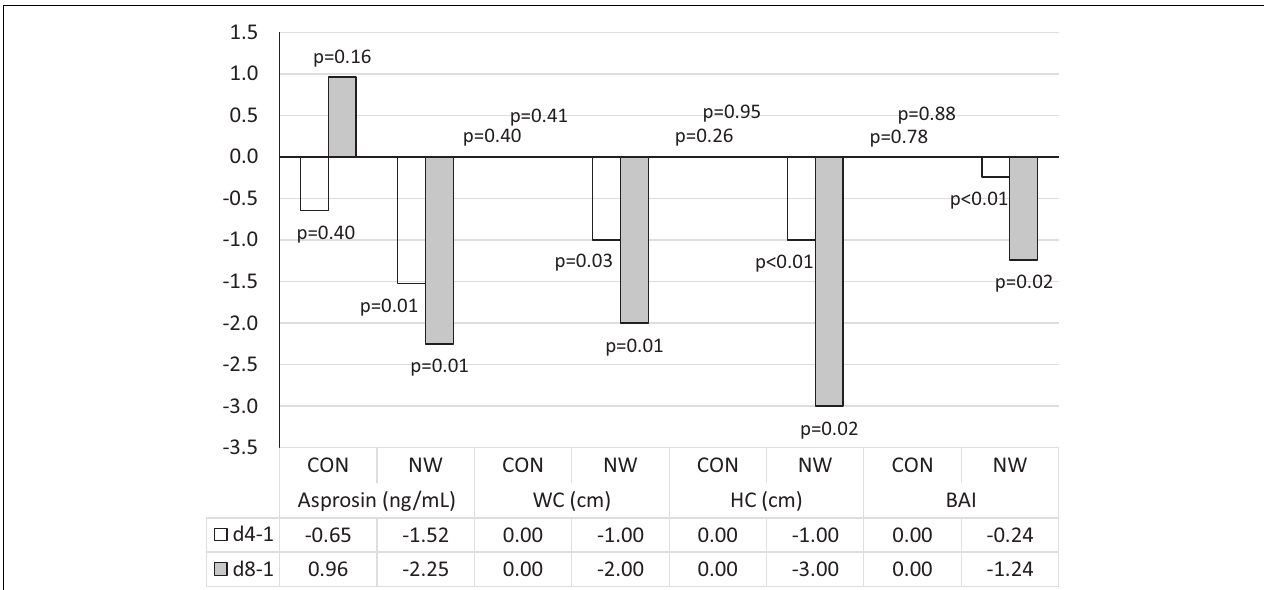
FIGURE 2 | Changes in analysed variables after 4 (d4-1) and 8 weeks (d8-1) of control (CON) tests and the Nordic walking (NW) compared to values at the beginning of the stage. Data are presented as medians (Me); p < 0.05 – statistically significant difference with regard to baseline value at a given stage; WC, waist circumference; HC, hip circumference; BAI, body adiposity index.